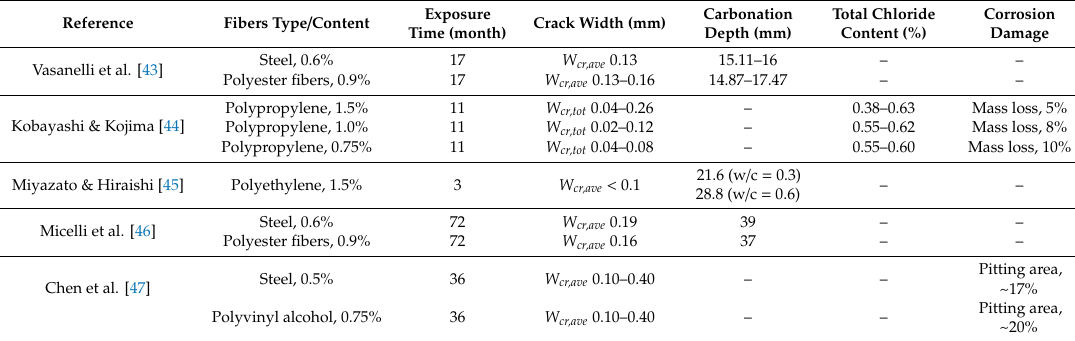
Table 2. A general overview of the influence of cracks in FRC on the corrosion of reinforcing steel. Note that W cr,ave is the average crack width, while W cr,total is the total crack